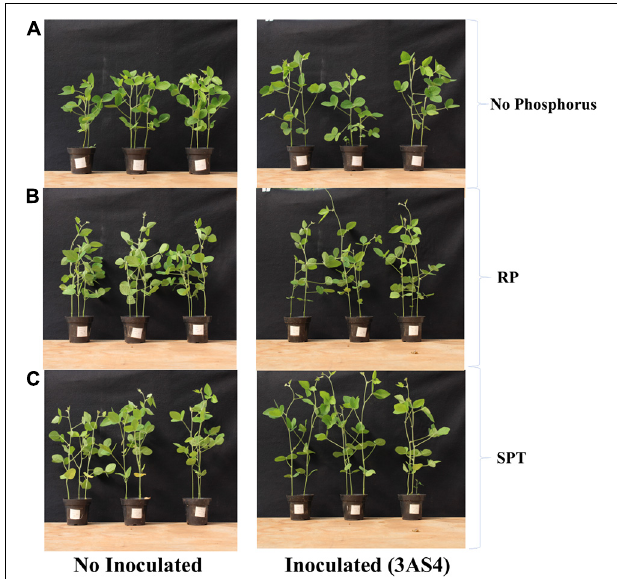
FIGURE 5 | Evaluation of the height of the soybean plants 6 weeks after inoculated with the 3AS4 strain with two different sources of phosphorus. (A) Soybean plants without inoculation of 3AS4 (left), inoculated with 3AS4 isolate and no additional phosphorus. (B) Soybean plants without inoculation of 3AS4 (left), inoculated with 3AS4 isolate and Rock phosphate (RP) at 40 kg ha − 1 . (C) Soybean plants without inoculation of 3AS4 (left), inoculated with 3AS4 isolate and Single super phosphate (SPT) at 40 kg ha − 1